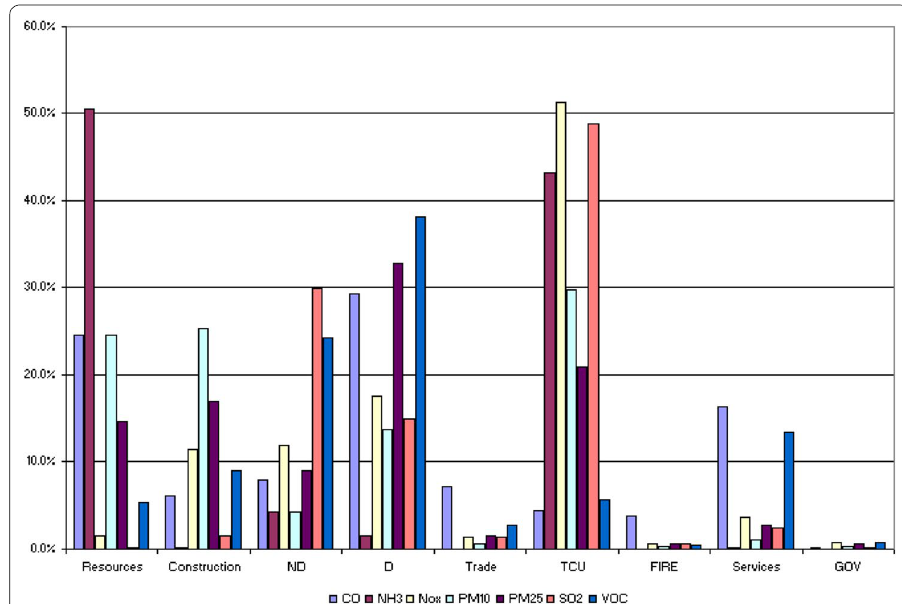
Fig. 9 Percentage distribution of seven air pollutant emissions in the base year (1999)